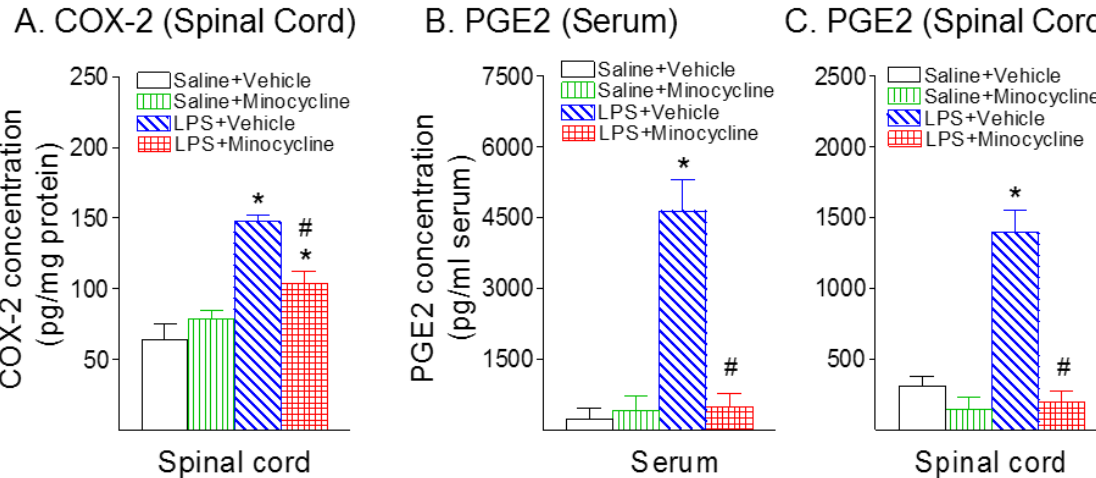
Figure 6. Minocycline attenuated systemic LPS exposure-induced increases in cyclooxygenase-2 (COX-2) in the rat spinal cord ( A ), and prostaglandin E2 (PGE2) in the rat serum ( B ) and spinal cord ( C ) 24 h (P6) after LPS injection. ( A ), Following LPS injection, the concentration of COX-2 in the spinal cord was elevated compared with the control group in the P6 rats. Minocycline attenuated an LPS-induced increase in the concentration levels of COX-2 in the spinal cord of P6 rats. ( B , C ), The concentration levels of PGE2 24 h (P6) following LPS injection in the serum ( B ) and spinal cord ( C ) were elevated compared with the control group. Minocycline attenuated an LPS-induced increase in the concentration levels of PGE2 in the serum and spinal cord of P6 rats. The results are expressed as the mean ± SEM of eight animals in each group and analyzed by two-way ANOVA, followed by the Student–Newman–Keuls test. * p < 0.05 represents a significant difference for the LPS + Vehicle group compared with the Saline + Vehicle group. # p < 0.05 represents a significant difference for the LPS + Minocycline group compared with the LPS + Vehicle group. ( n = 8).